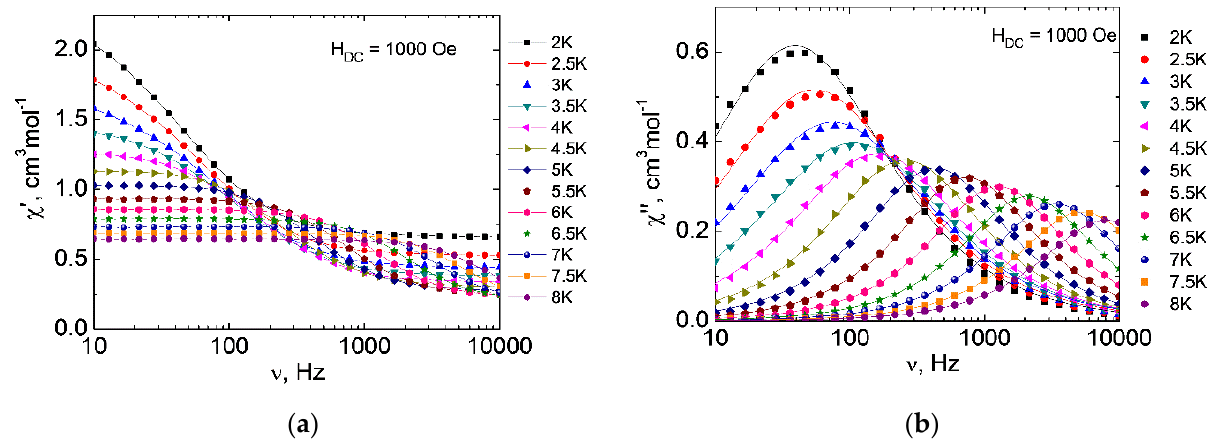
Figure 6. Frequency dependences of the real χ (cid:48) ( a ) and imaginary χ (cid:48)(cid:48) ( b ) components of the ac magnetic susceptibility of 1 in the 1000 Oe field (lines are guides for the eyes ( χ (cid:48) ), approximation using the generalized Debye model ( χ (cid:48)(cid:48)